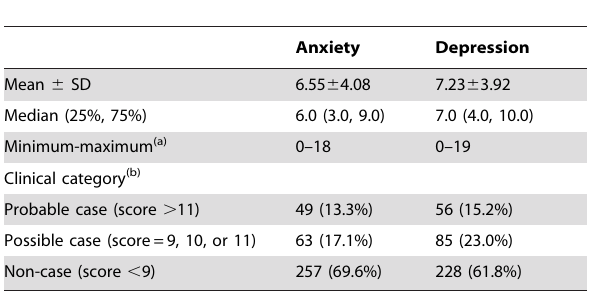
Table 5. Anxiety and depression scores at baseline, and numbers of participants in the three clinical categories